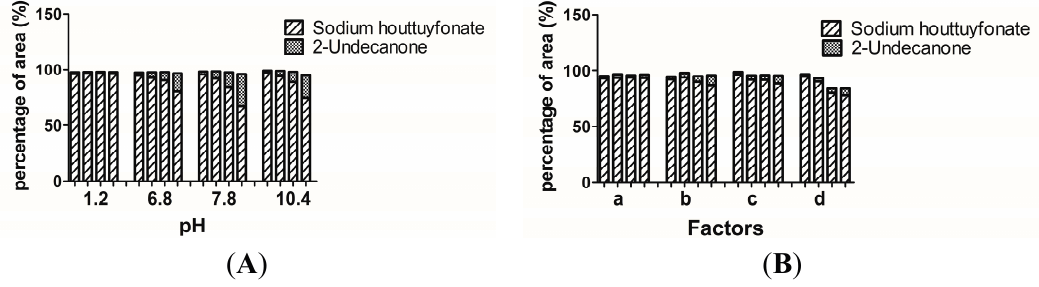
Figure 6. Stability of sodium houttuyfonate under different conditions. Four columns of each group from left to right were measured at 0.5, 1, 2 and 4 h, respectively. ( A ) Effects of pH; and ( B ) simulated gastrointestinal environments. a: Simulated gastric fluid; b: Solution of pepsin; c: Simulated intestinal fluid; and d: Solution of trypsin. The experiments were conducted in a water bath at 37